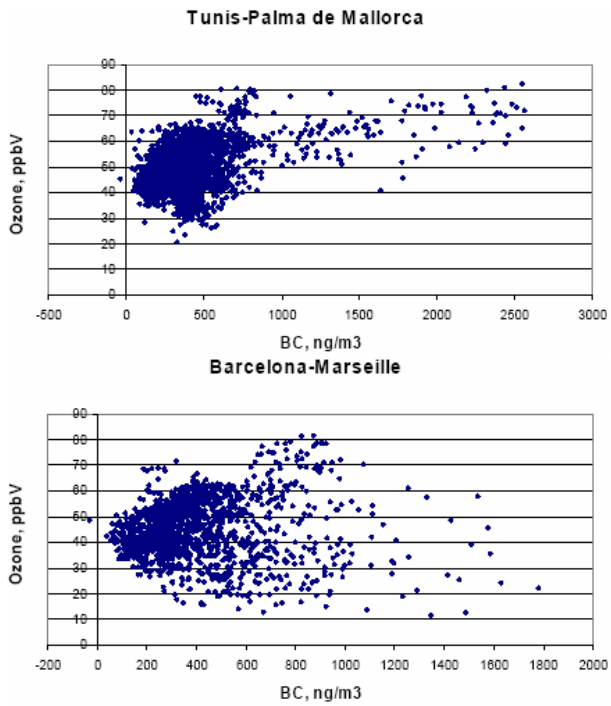
Fig. 10. Scatter plot of BC vs. ozone for all measurements performed during the summer periods (June, July, August) of the years 2006 and 2007 along the legs Tunis – Palma de Mallorca (upper) and Barcelona - Marseille.